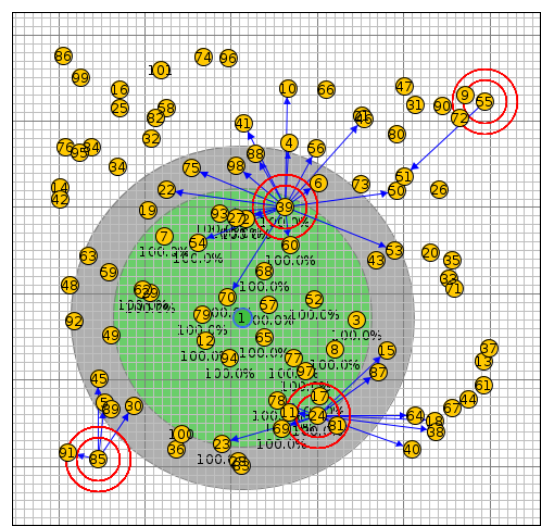
Figure 10. Scenario IV with 100 nodes.